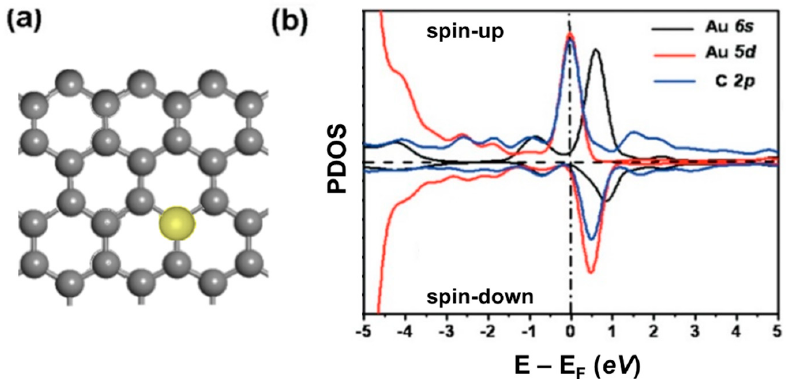
Figure 4. Single Au atom adsorbed on defective graphene. ( a ) Atomic configuration of adsorption of Au atom. ( b ) DOS projected on Au and C. Please note that the magnetic moment is on the Au atom.